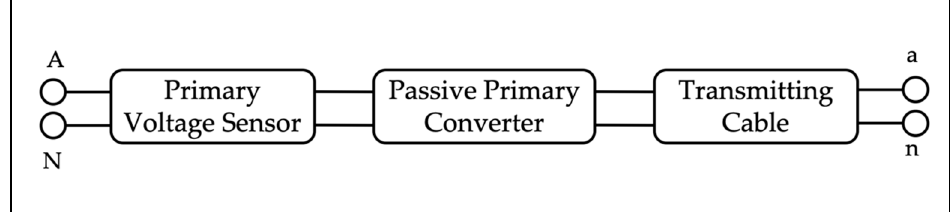
Figure 1. Main structure of a generic passive low ‐ power instrument transformer (LPIT).